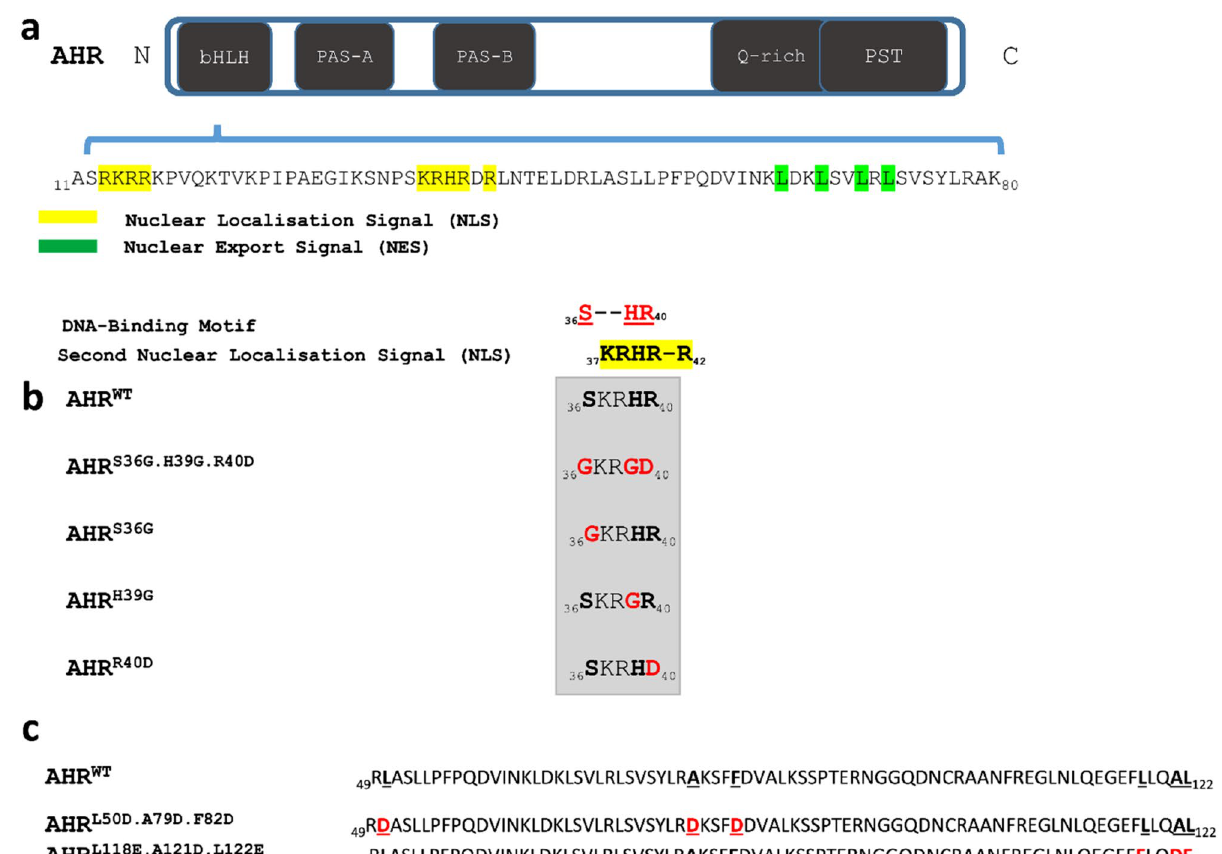
Figure 1. Design of AHR mutants to study DNA-binding and ARNT dimerization. ( a ) Domain architecture of the AHR. The bipartite nuclear localization signal (NLS) and a nuclear export signal (NES) are indicated as amino acid sequence. Graphical representation of mutated amino acids in the DNA-binding motif ( b ) and ARNT-binding domain ( c ) of the